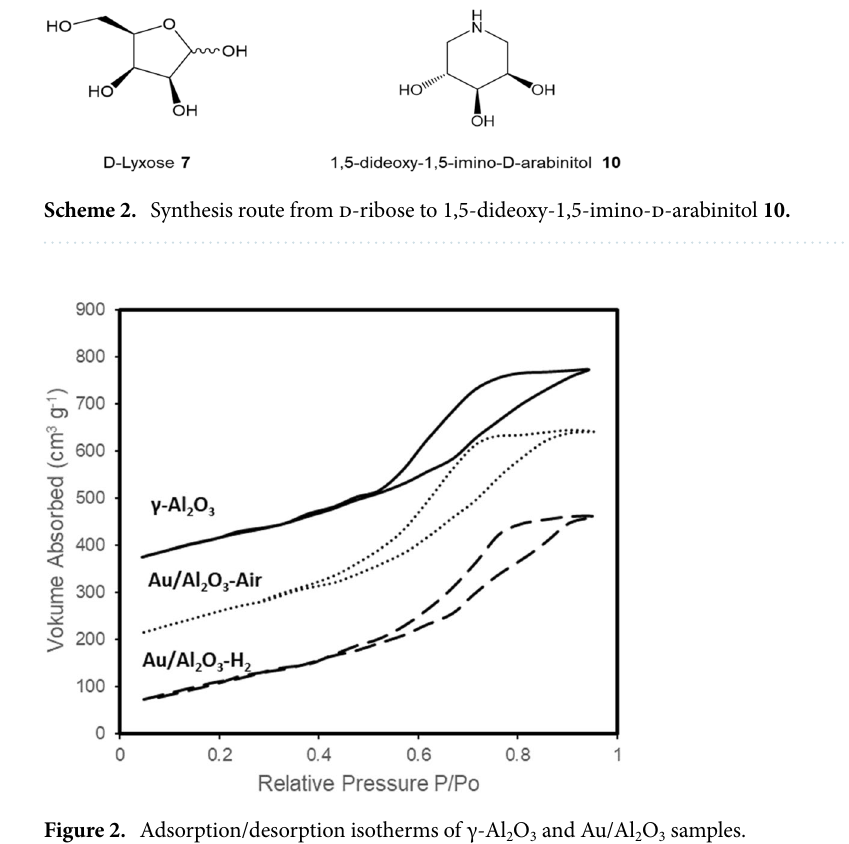
Figure 2. Adsorption/desorption isotherms of γ-Al 2 O 3 and Au/Al 2 O 3 samples.